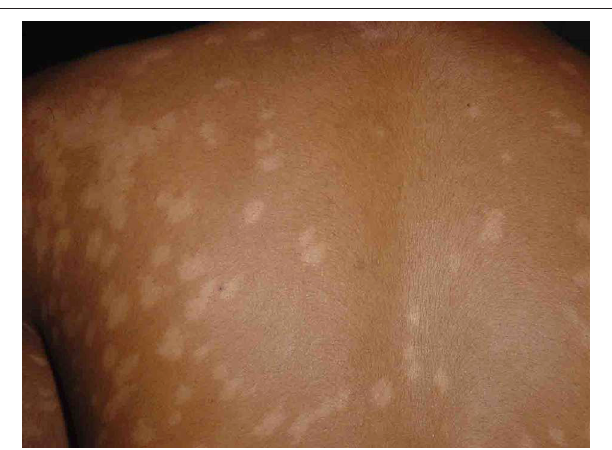
FIGURE 2 | A macular rash in a patient from Bangladesh; the macules vary in size and some are confluent.